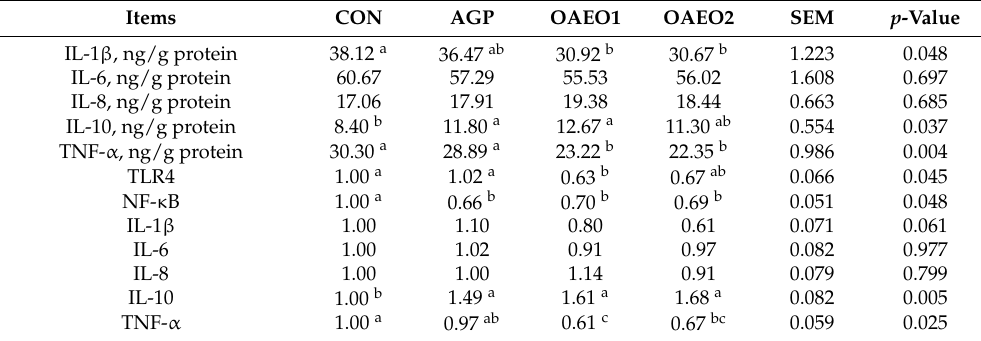
Table 7. Effect of OAEO on intestinal cytokine contents and TLR-4/NF- κ B signaling pathway-related gene mRNA levels of weaned